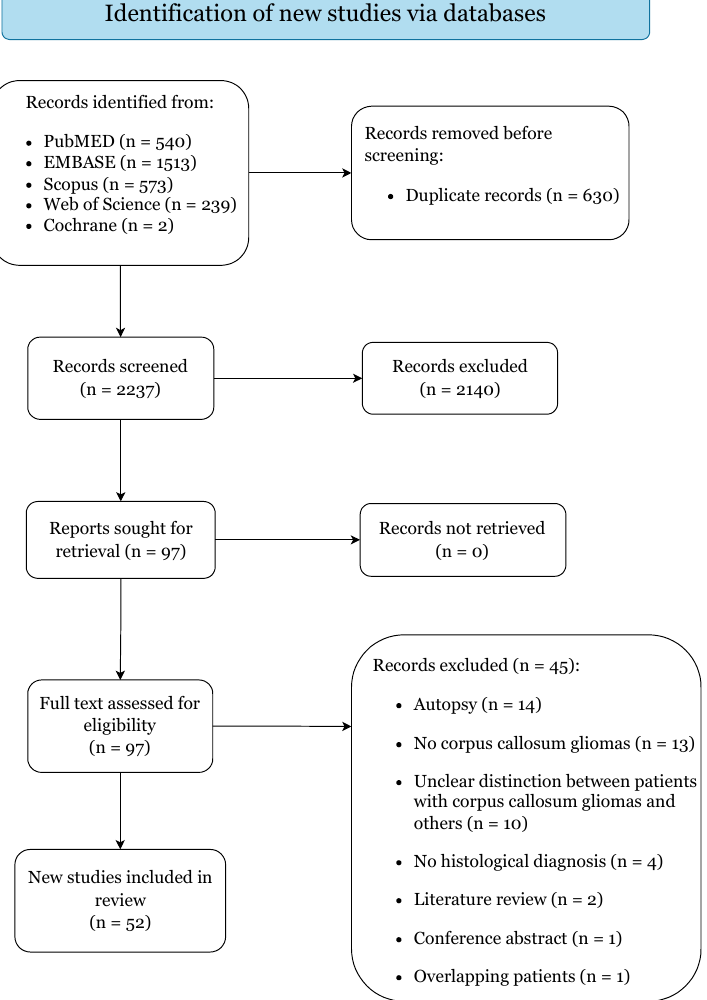
Figure 1. PRISMA 2020 flow diagram.